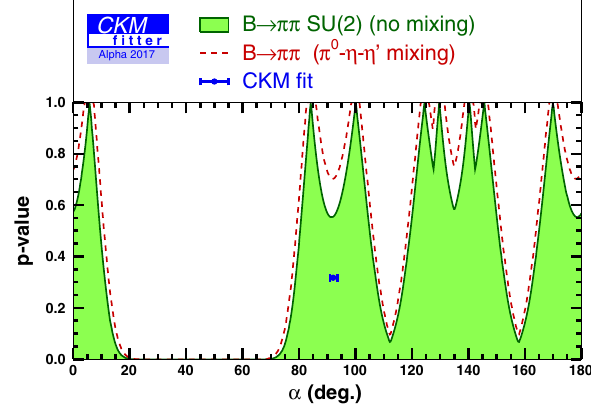
Fig. 15 Determination of α from the B → ππ system including π 0 – η – η (cid:5) mixing ( red dashed line ) and neglecting this mixing ( green shaded area [34,35]